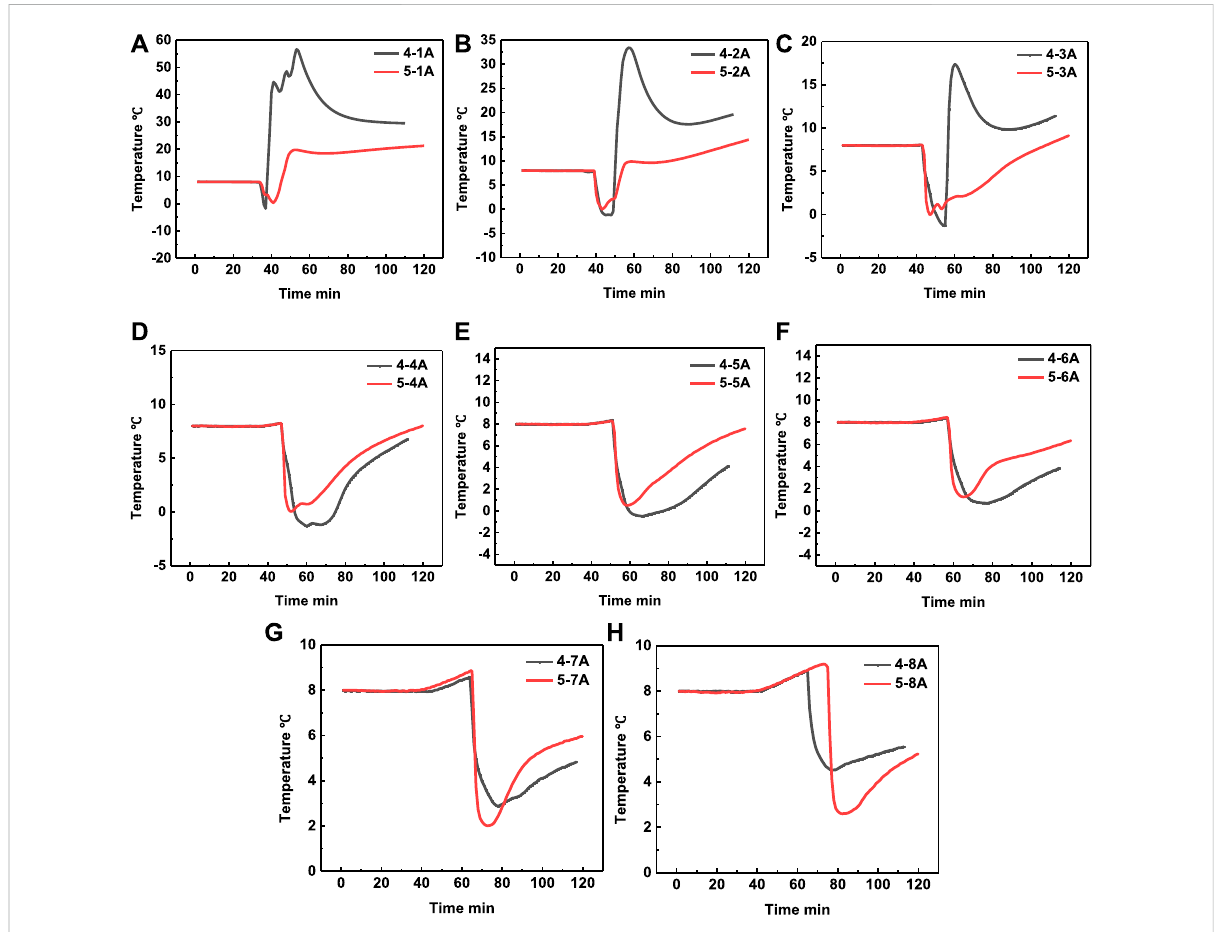
FIGURE 11 Temperature comparison in experiment 4 and experiment 5 at positon 1A (A) , positon 2A (B) , position 3A (C) , position 4A (D) , position 5A (E) , position 6A (F) , position 7A (G) and position 8A (H) ,